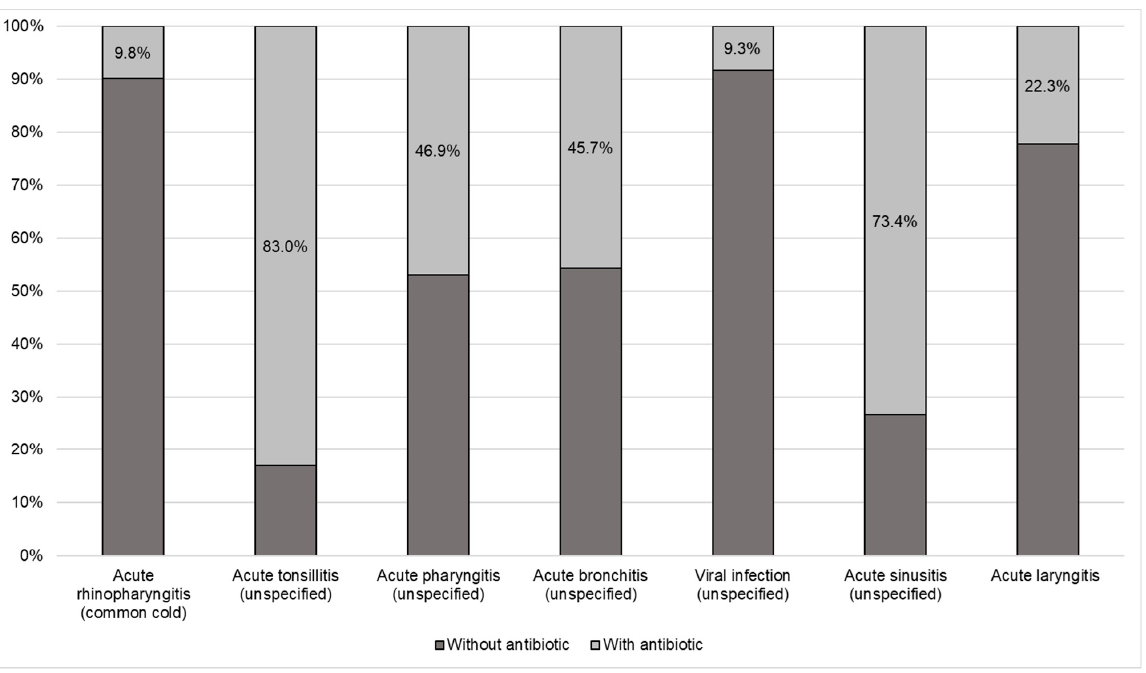
Figure 1. Proportion of antibiotic use according to the most frequent diagnoses in patients with viral respiratory tract infections, Colombia—2018.